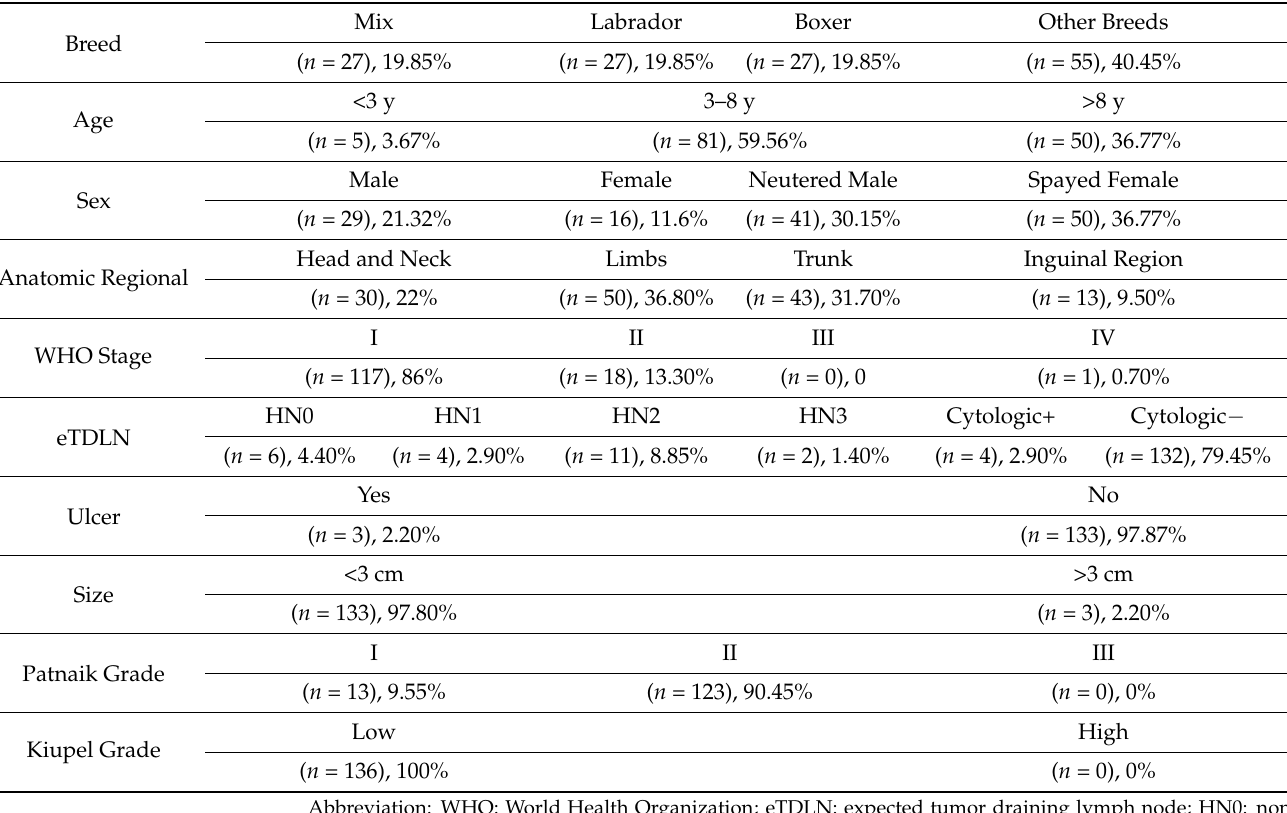
Table 1. Tumor characteristics and staging of 136 dogs affected by mast cell